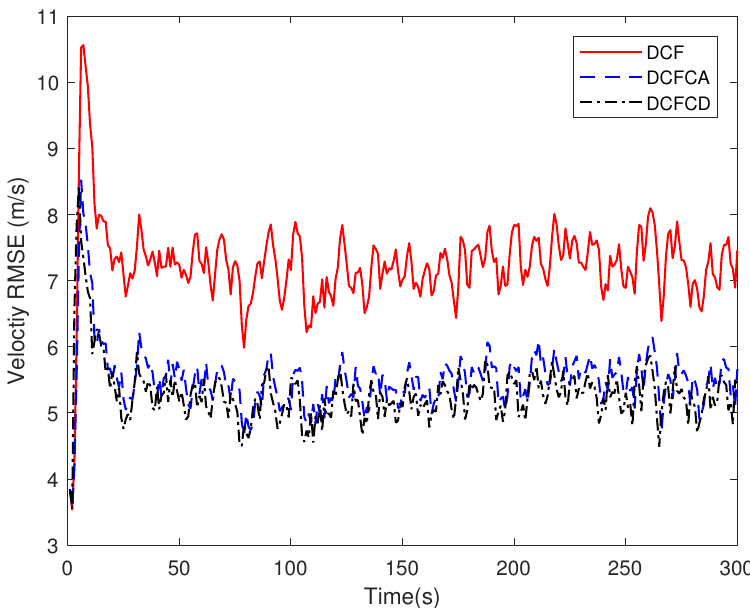
Figure 10. The velocity RMSE for different consensus filters of failure